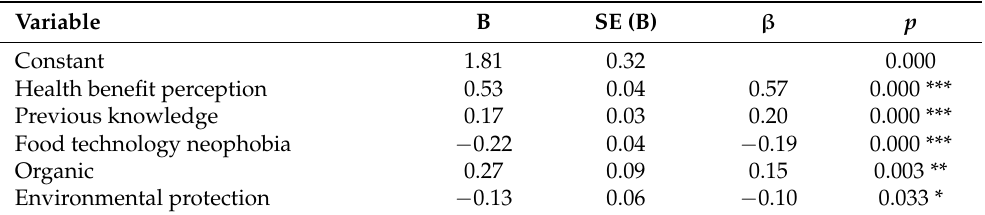
Table 3. Results from multiple linear regression analyses explaining consumers’ initial attitudes toward superfoods.